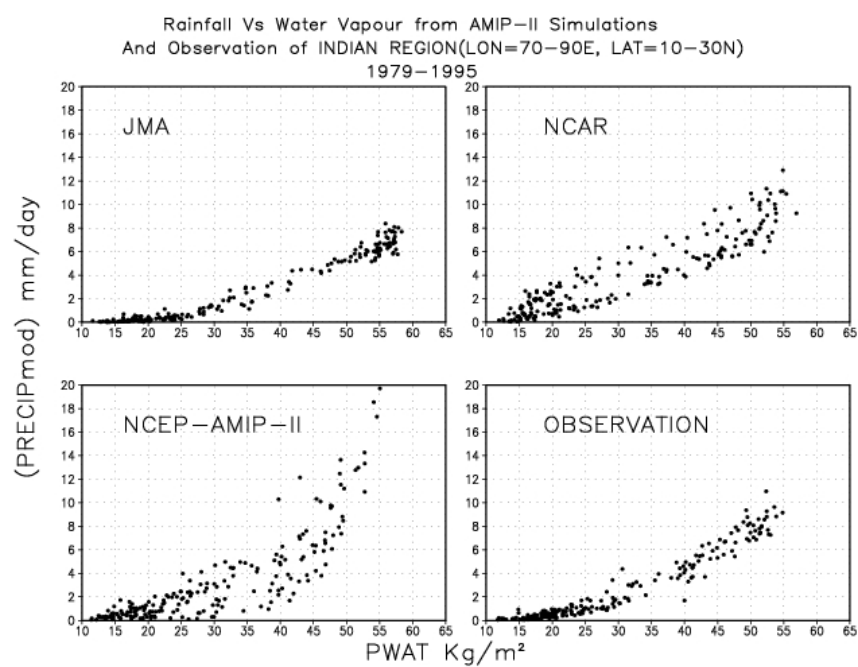
Fig. 6. Relationship between rainfall and integrated water vapour over India in NCEP, NCAR and JMA GCM and observations during